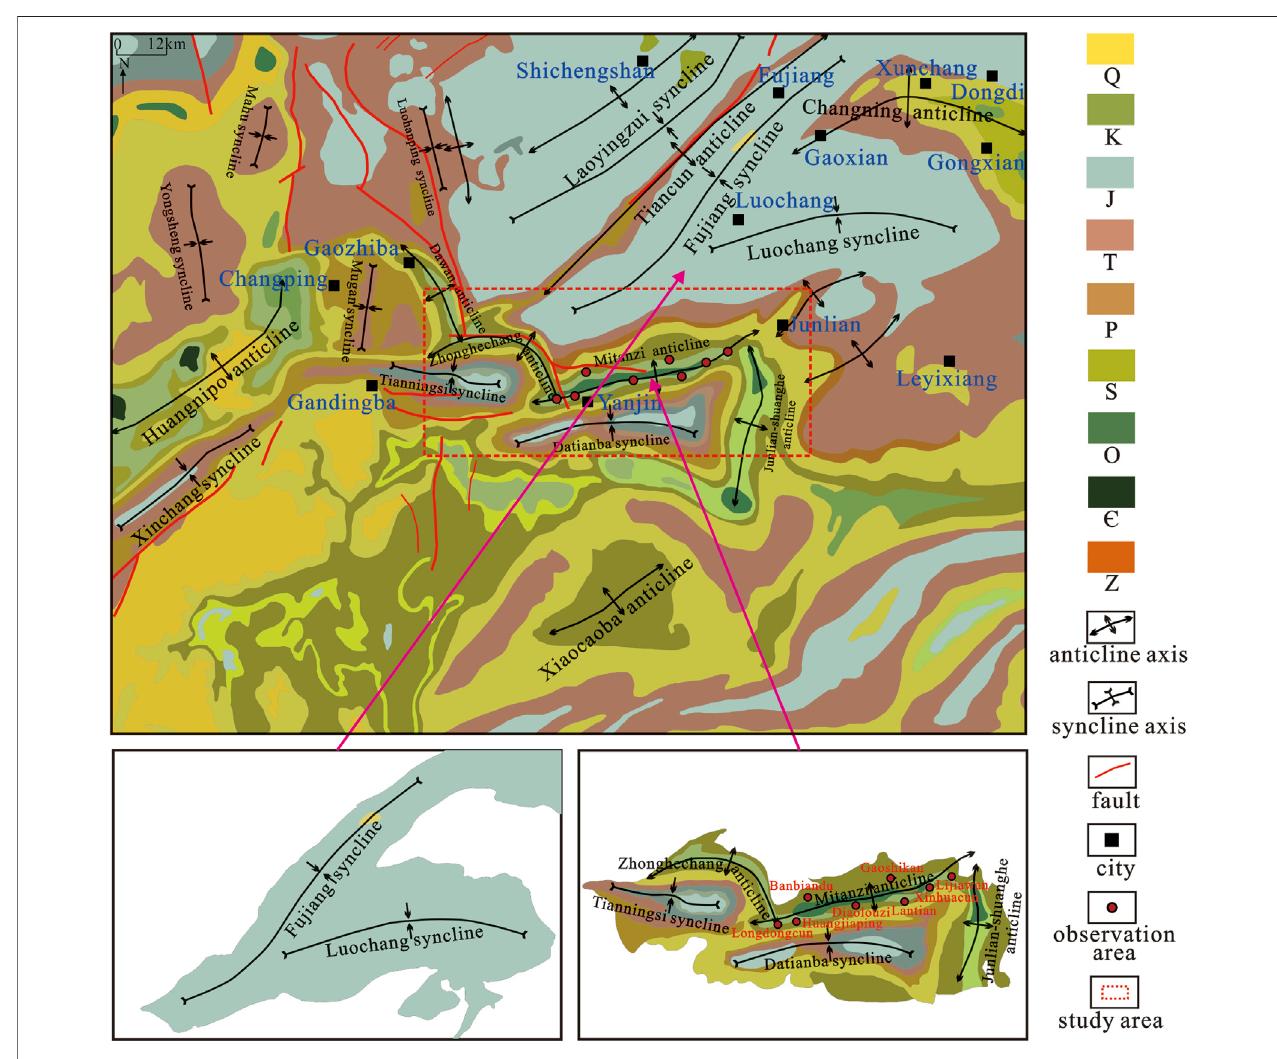
FIGURE 2 | Tracks of surface fold structures in the Shuanglong – Luochang